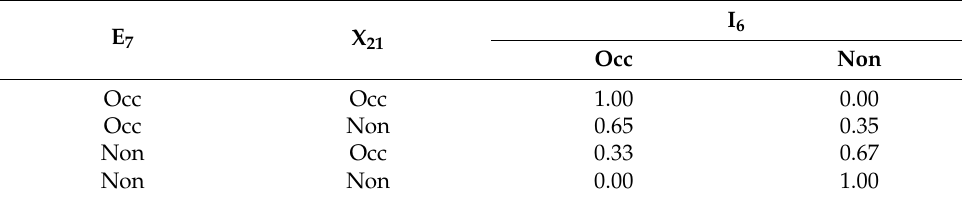
Table A5. The CPT of event I 6 (Internal corrosion; Occ: occurred; Non: non-occurred).